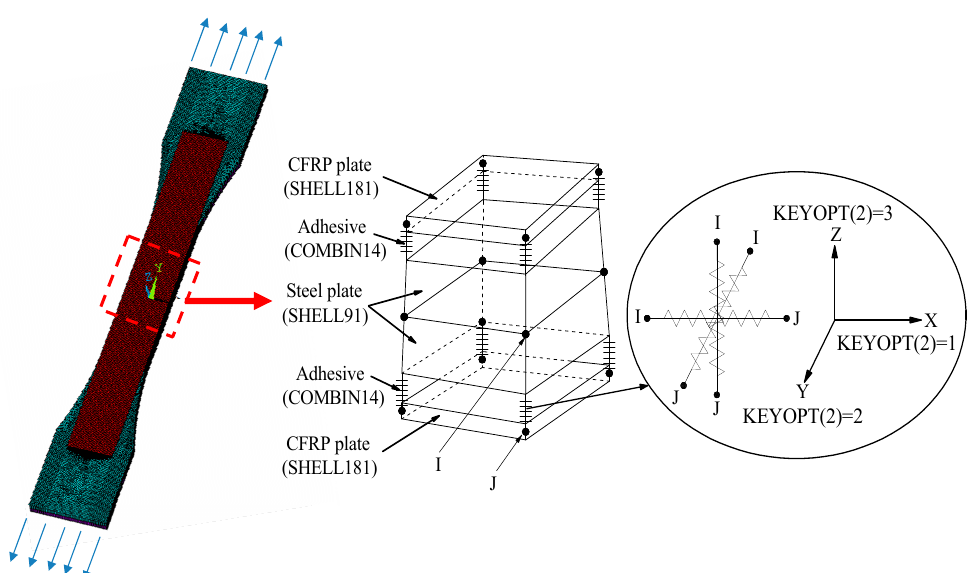
Figure 7. Element type and constraint relationship in the finite element models.